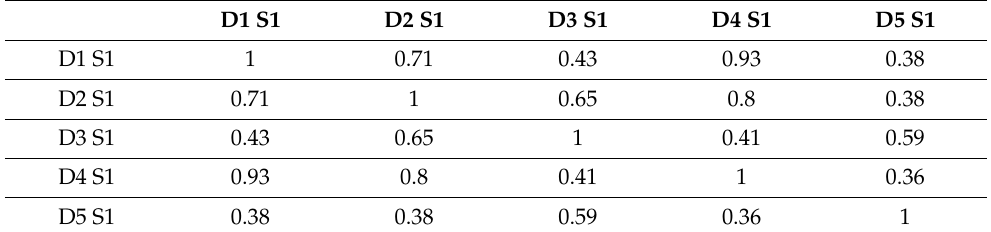
Table 3. Similarity